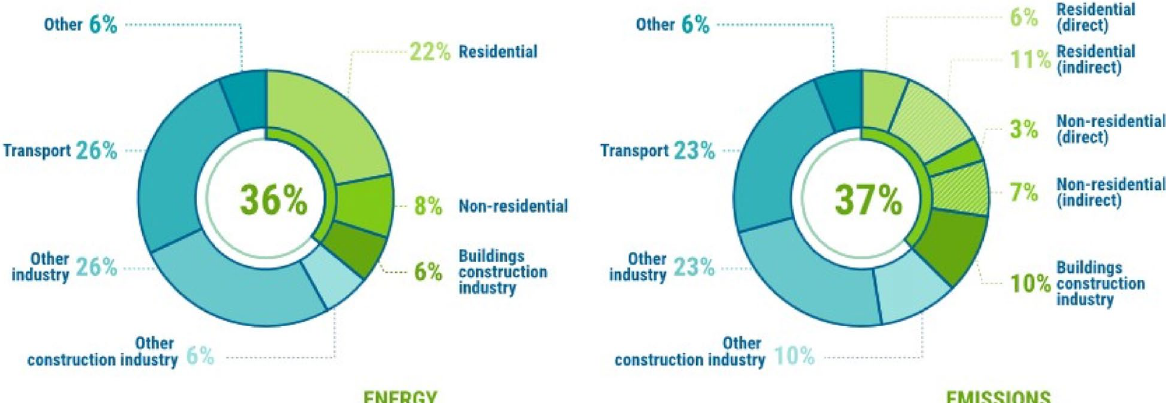
Fig. 1 Contribution of buildings and building construction industries in global energy consumption and greenhouse gas emissions. Source: UNEP